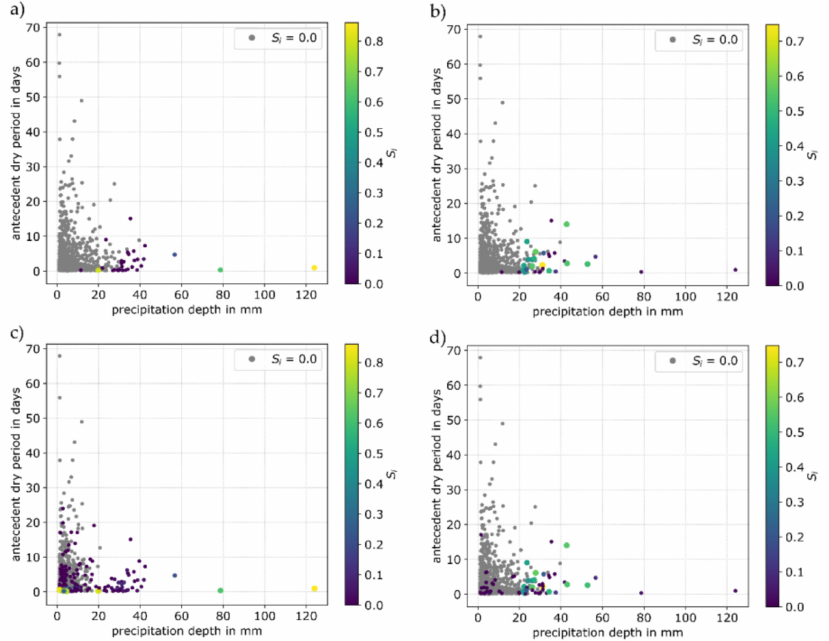
Figure 8. Results of storm event-based sensitivity analysis for the bio-retention cell. Si depending on storm event characteristics (precipitation depth, antecedent dry period) and bio-retention cell parameters: ( a ) Si for runoff volume and storage seepage rate; ( b ) Si for runoff volume and berm height ; ( c ) Si for storage change/groundwater recharge and storage seepage rate ; ( d ) Si for storage change/groundwater recharge and berm